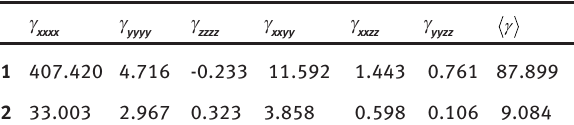
Table 4: All static g(0;0,0,0) components and g (0;0,0,0) ( × 10 -37 esu) values for 1 - 2 computed by TDHF method with 6-31G( d ) basis